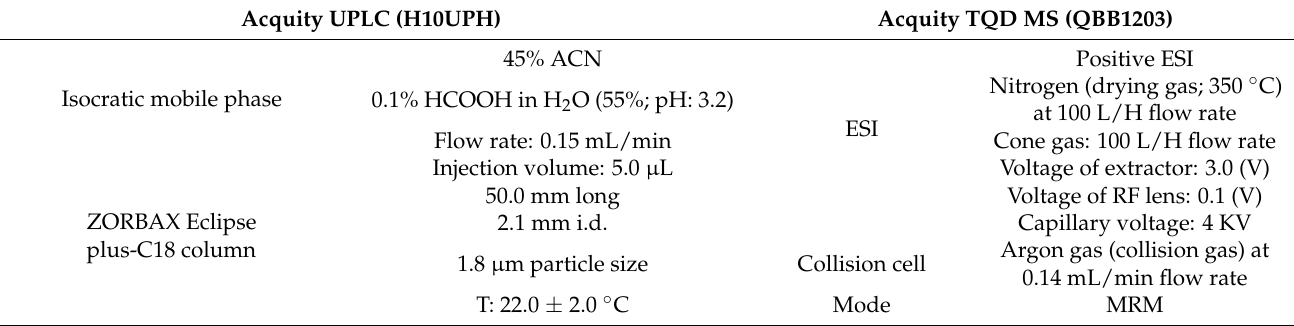
Table 1. Analytical parameters of liquid chromatography and mass detection.